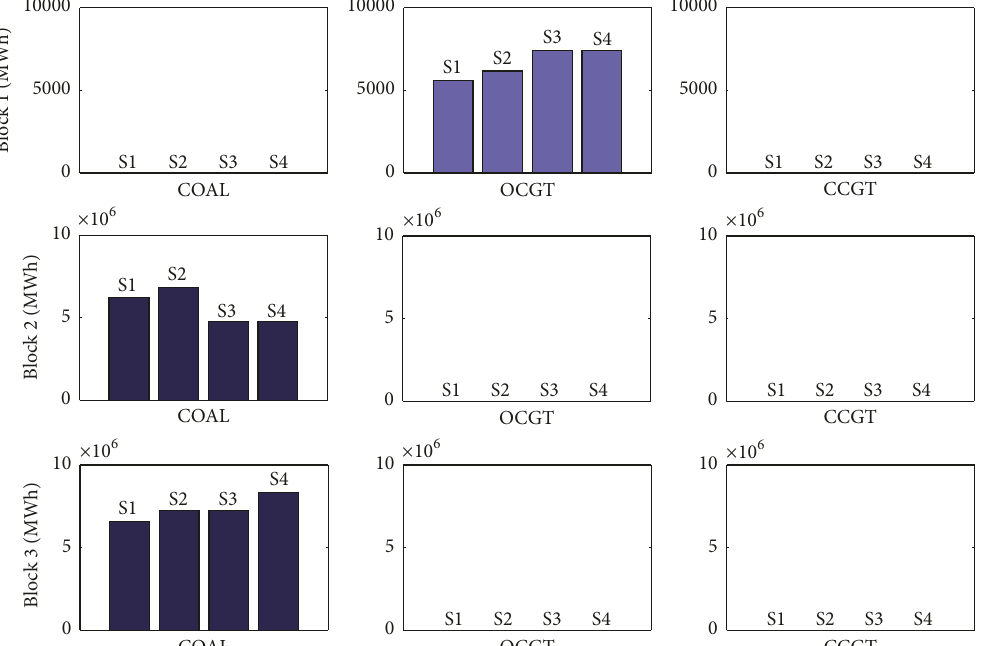
Figure 6: Traditional solution use for each scenario.